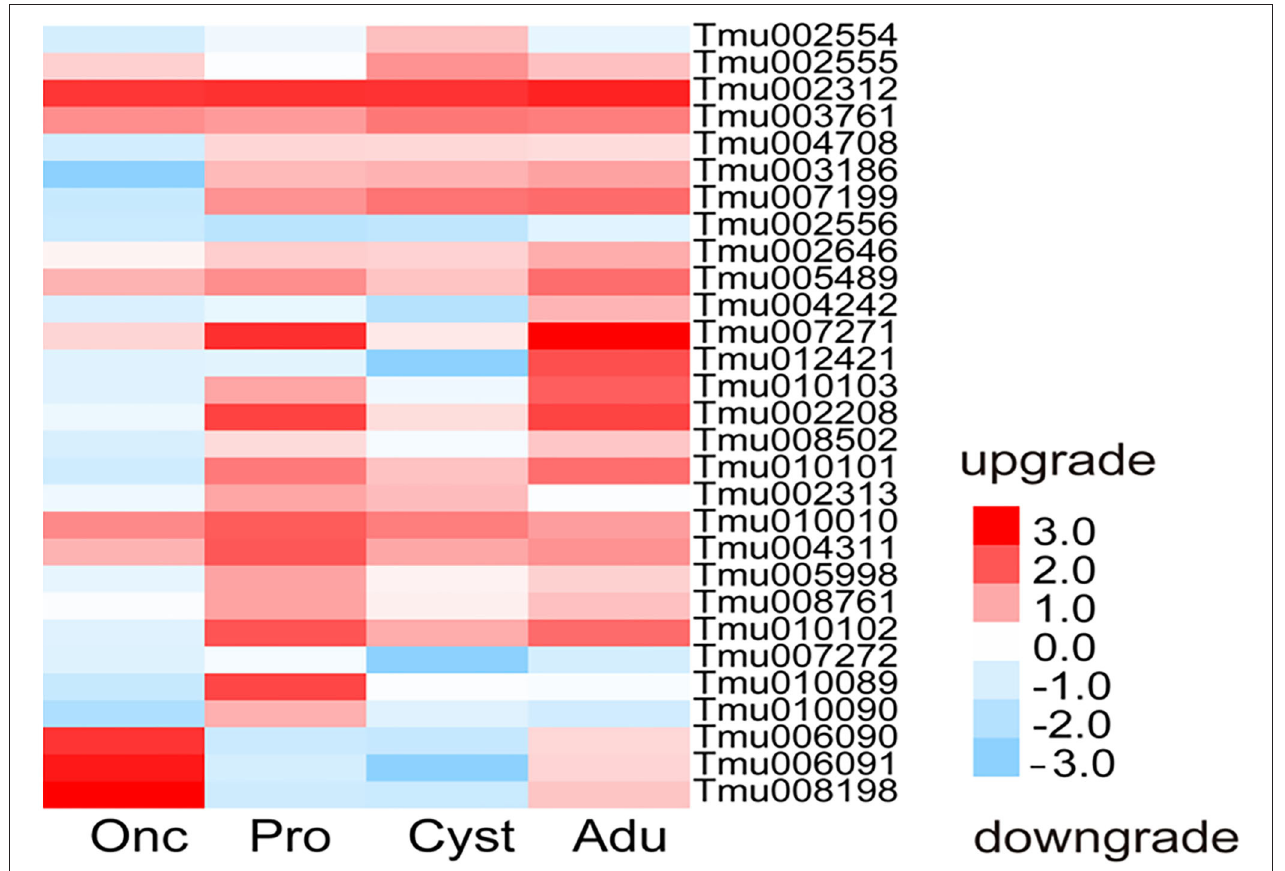
FIGURE 4 | Heatmap of the expression of inhibitor-associated genes in the transcriptomes of T. multiceps